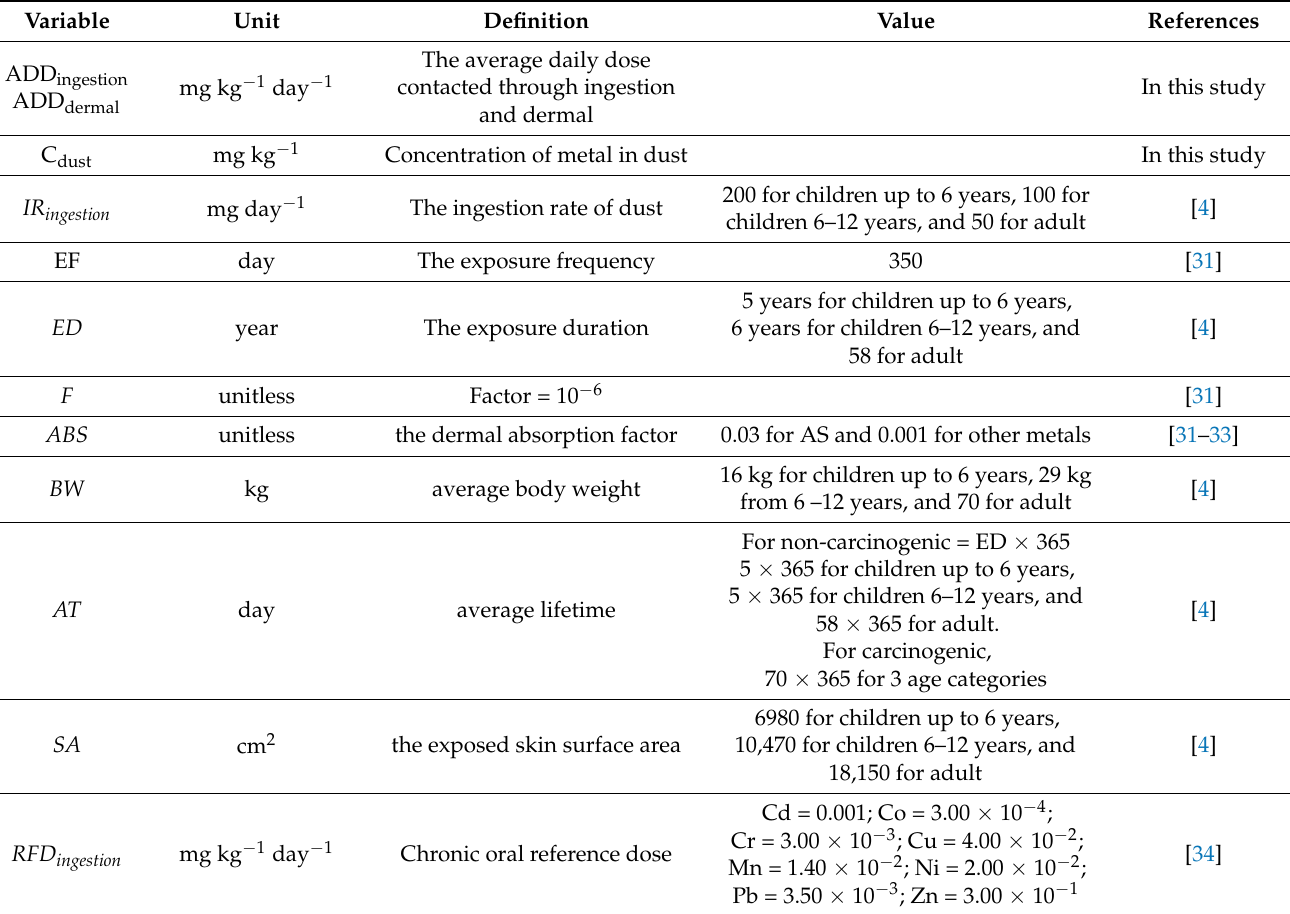
Table 1. Definitions of the parameters and values of the variables for the human health risk